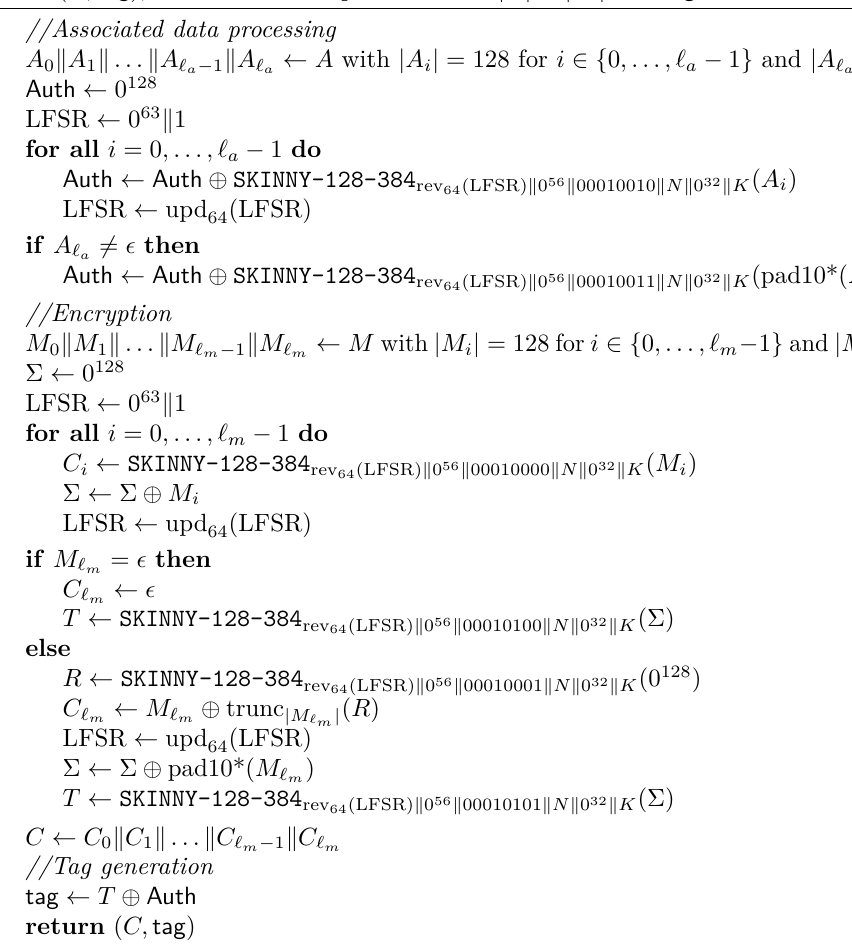
Algorithm 5 The authenticated encryption algorithm SKINNY - AEAD - M2 - Enc ( K, N, A, M ) In: 128-bit key K , 96-bit nonce N , associated data A , message M (both arbitrarily long) Out: ( C, tag ), where C is the ciphertext with | C | = | M | and tag is a 128-bit tag //Associated data